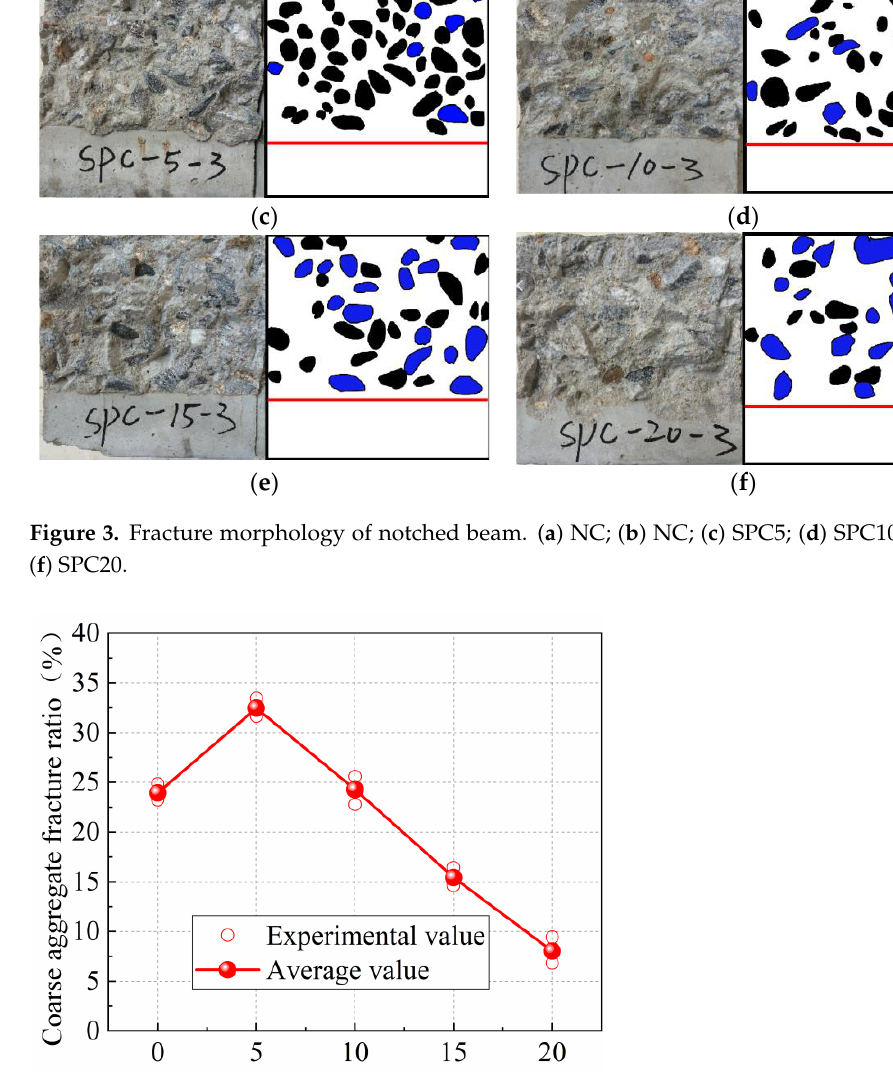
Figure 4. Relationship between coarse-aggregate fracture surface ratio R and steel-slag-powder replacement